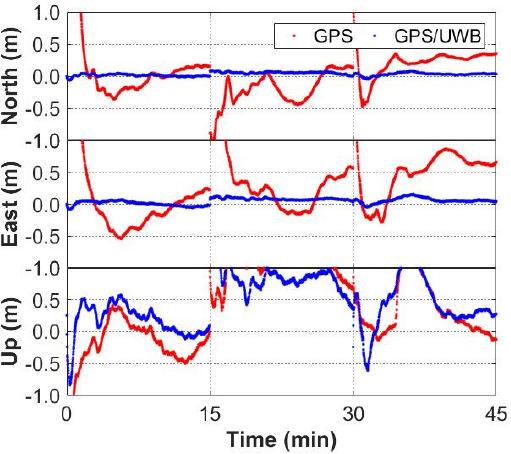
Figure 10. Convergence performance of GPS-only and GPS/UWB solutions for group A, B and C.